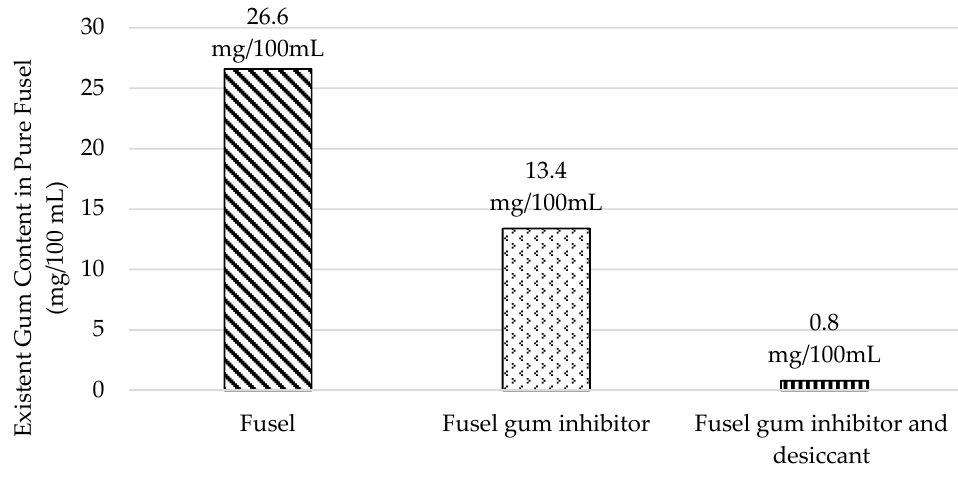
Figure 2. Reducing water gum content in pure fusel oil.